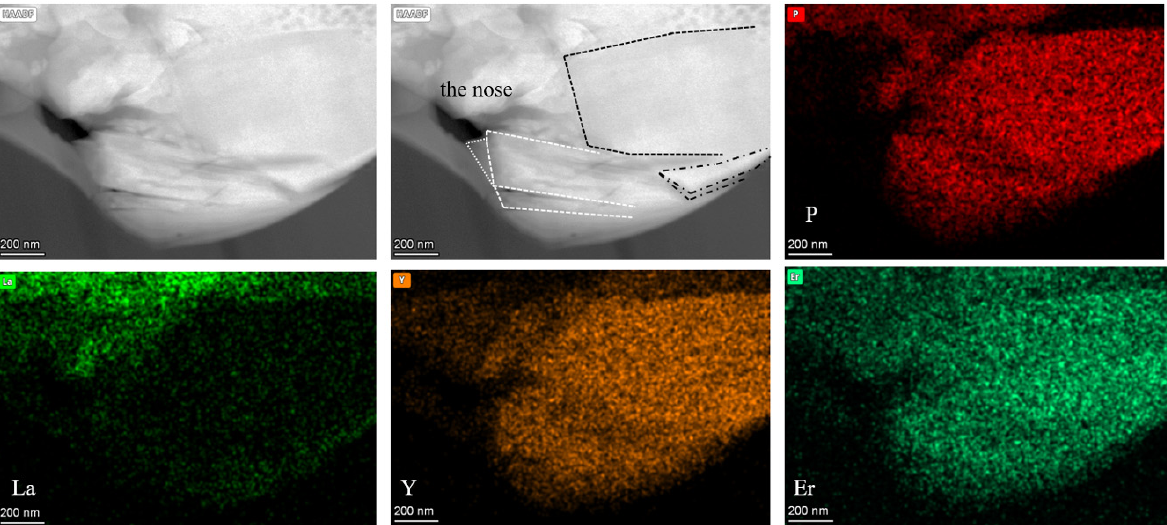
Figure 15. Area 1003. Clockwise from upper left: HAADF image of area; HAADF image with xenotime crystals outlined; P element map; Er element map; Y element map; La element map.